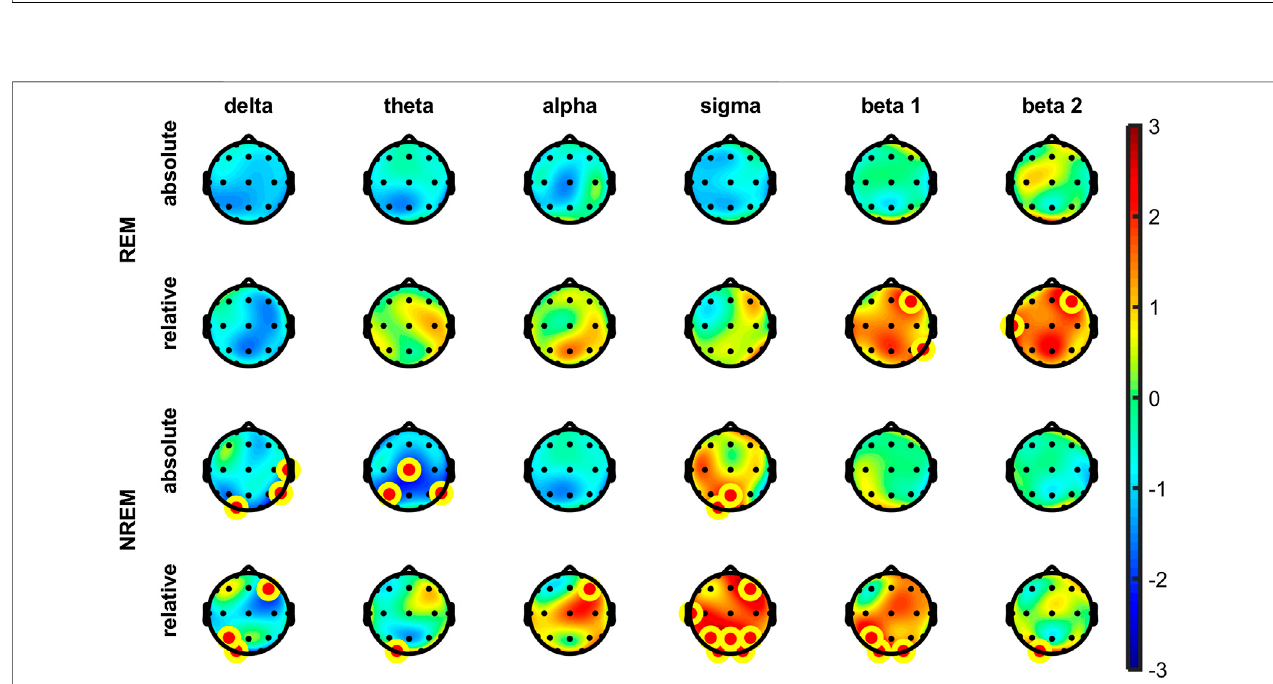
FIGURE2| Topographicplotsofdifferencesint-values(Psilocybin – Placebo)inabsolute (top) andrelative (bottom) spectralpowerforeachfrequencybandinthe REM (top) and NREM (bottom) sleep across the entire sleep period. The yellow-red dot denotes electrodes signi fi cant at p < 0.05 (uncorrected). No differences remained signi fi cant in both absolute and relative spectral power after correcting for multiple comparisons (Sidak method, all frequency bands, all 19 derivations).